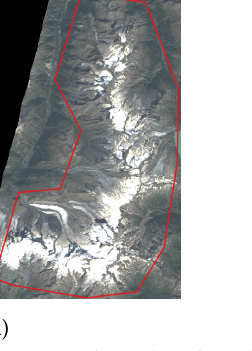
Figure 1. The red outline defines our study area. This visualization is based on data acquired on 3 September 2019 by Landsat 8. ( a ) True color image of the study area. ( b ) (Green/NIR/SWIR) image of the study area. ( c ) Study area projected upon